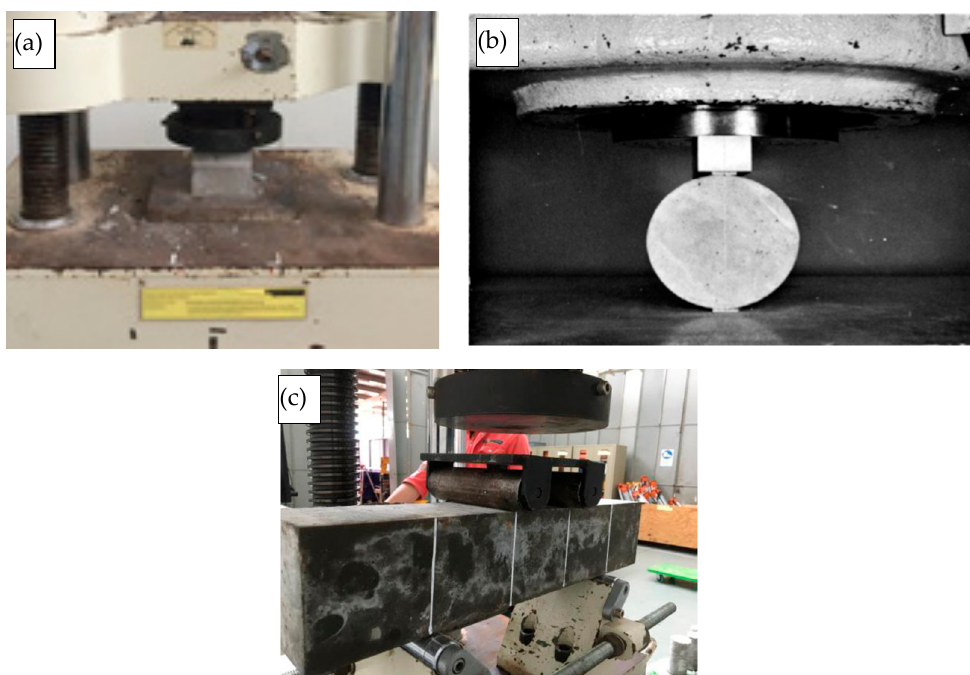
Figure 3. ( a ) compression ( b ) splitting tensile and ( c ) flexural tests setup.